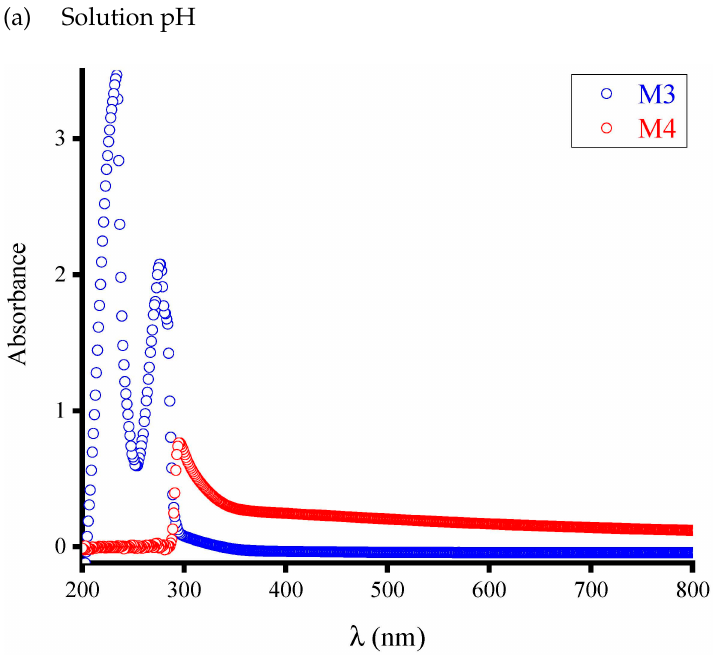
Figure 10. The UV-Vis spectra of M3 and M4 in aqueous solution (10 mg/100 mL) at pH = 7.